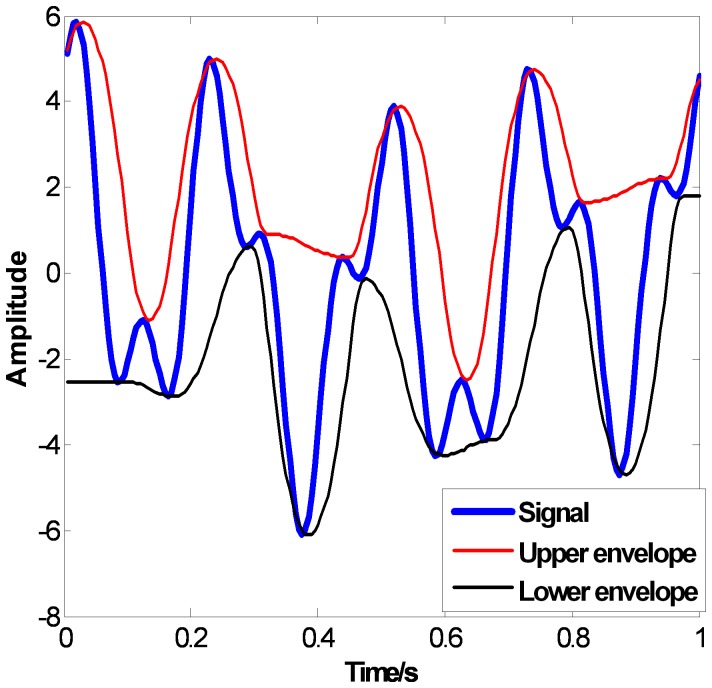
the PPI envelopes.